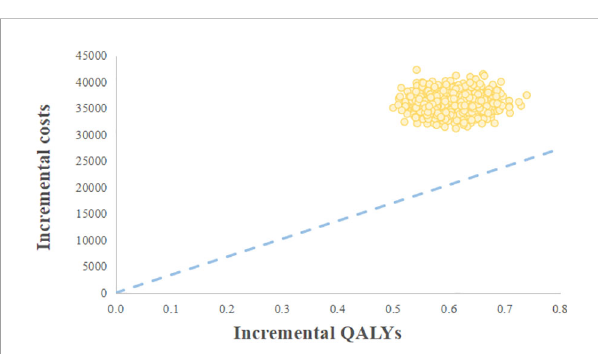
FIGURE 3 Cost-effectiveness scatter plot. WTP, Willingness-to-pay; QALY, Quality-adjusted life